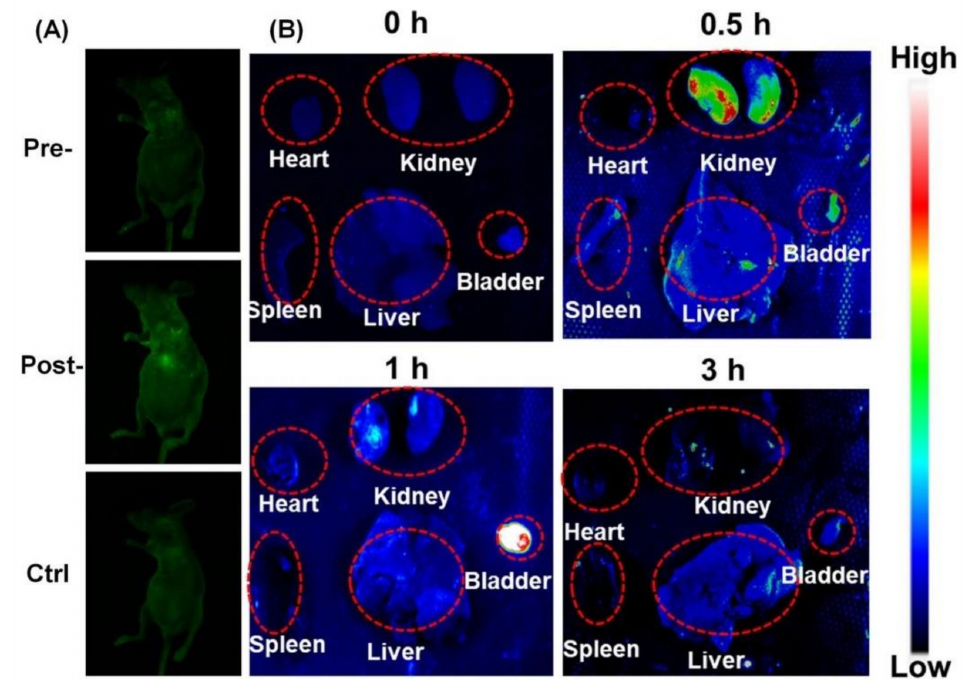
Figure 11. ( A ) In vivo imaging and ( B ) ex vivo imaging of a mice after intravenous injection of CQDs. Reproduced with permission from ref. [122], published by Springer Open,